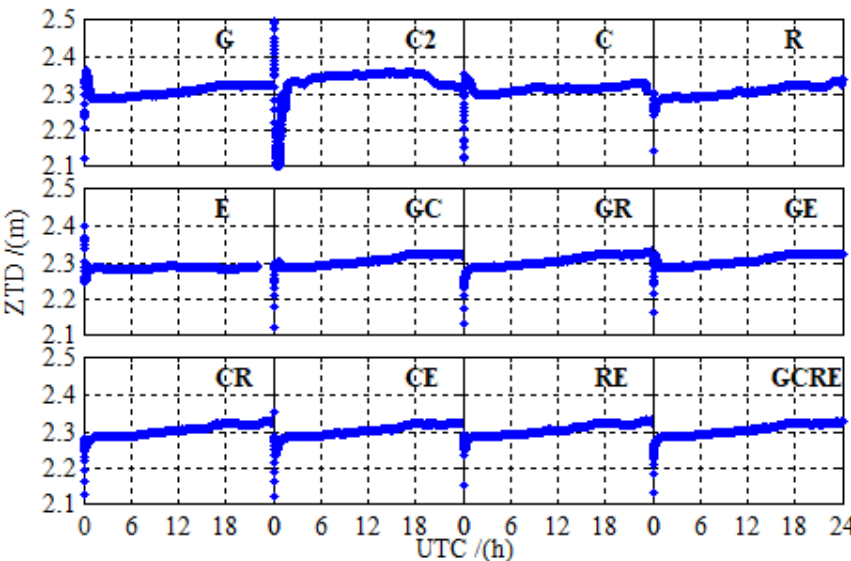
Figure 9. The solutions of zenith troposphere delay (ZTD) at BRCH for 12 different processing cases on DOY 024 in 2019.